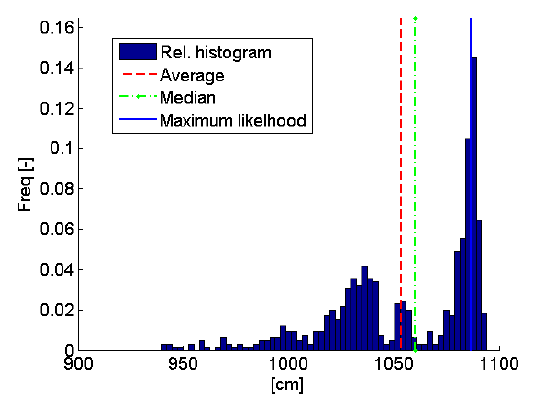
Figure 2. Sample indoor